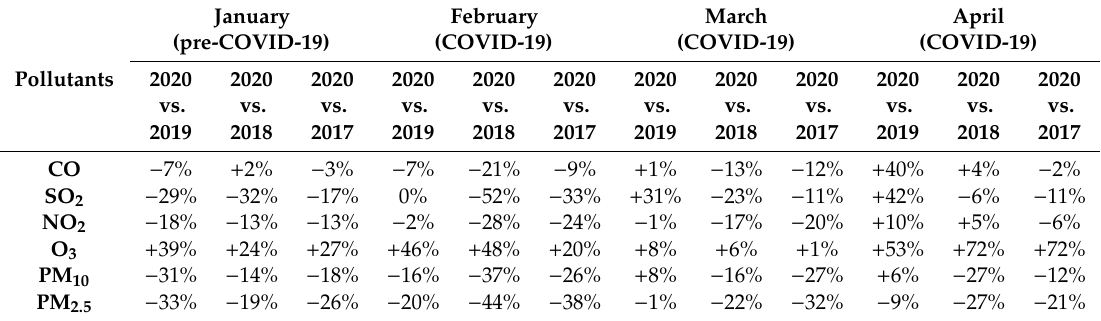
Table 2. Relative changes of roadside emissions of 2020 over 2017–2019 in each month. Negative and positive percentages indicate emission reductions and increases, respectively.